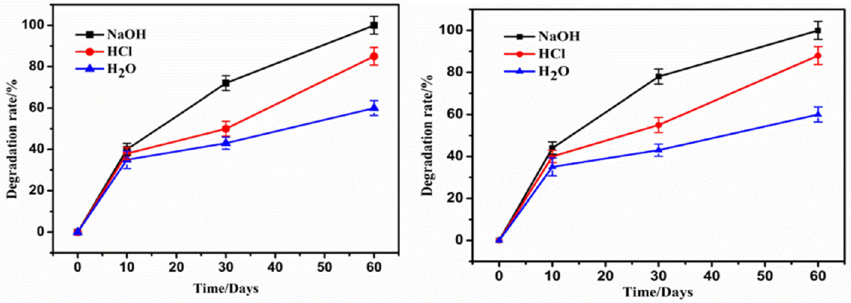
Figure 2. Degradation of the porous film in 0.1 mol/L ( left ) and 0.5 mol/L ( right ) solution.